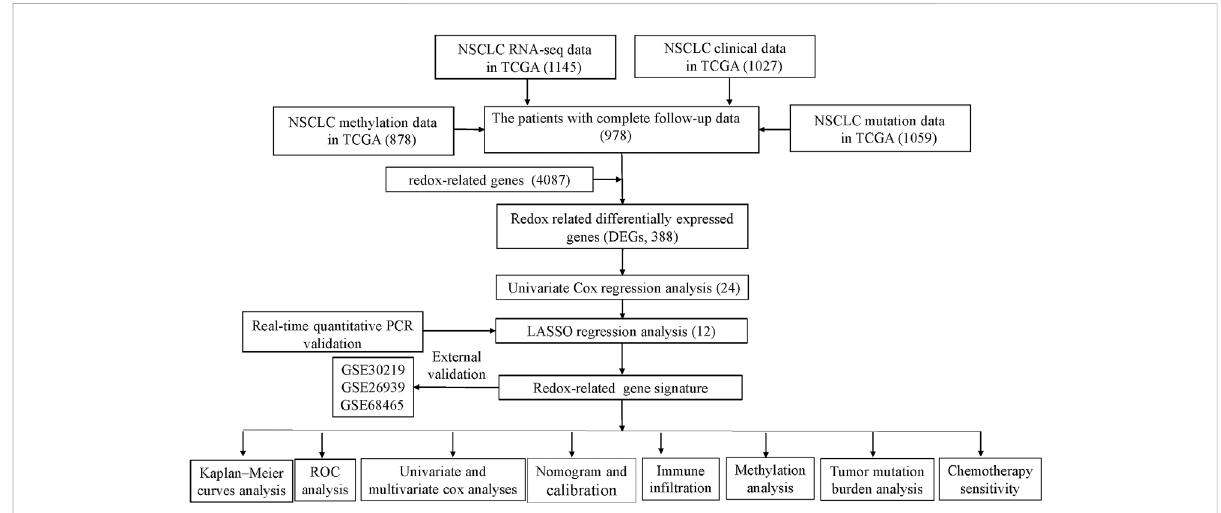
FIGURE 1 Schematic fl owchart representing the procedure followed for establishing the gene signature, and the main fi ndings of the study. Numbers within parenthesis indicate the size of the sample obtained. NSCLC, Non-small cell lung cancer; PCR, polymerase chain reaction; LASSO, least absolute shrinkage, and selection operator; ROC: receiver operator characteristic; TCGA, The Cancer Genome Atlas.